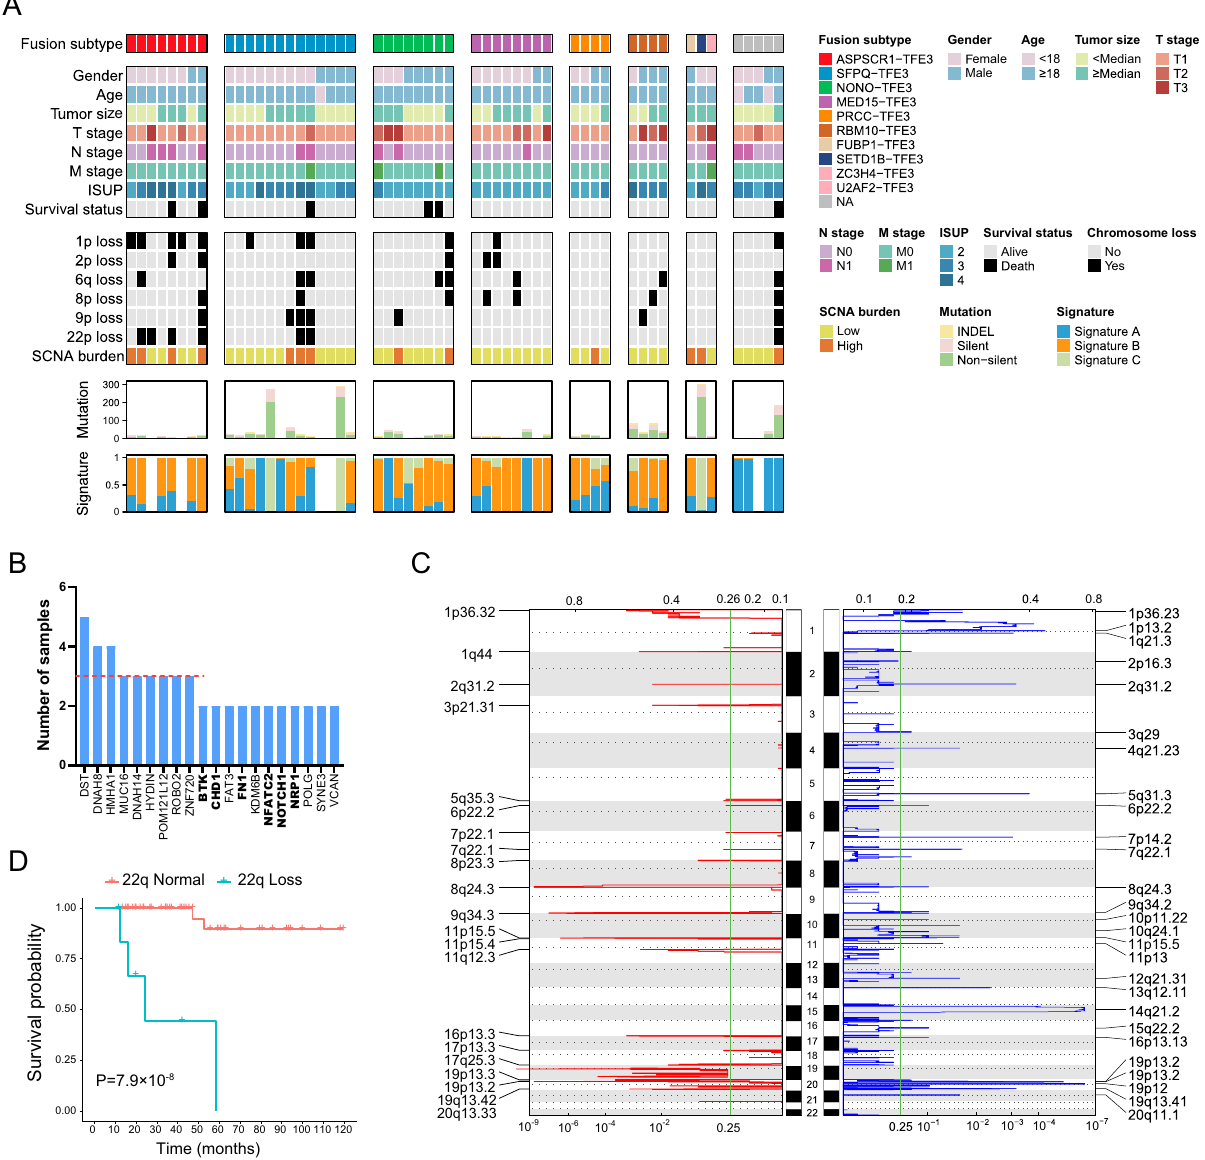
Fig. 3 The mutational landscape of TFE3-tRCC. A Clinical features and molecular data for 53 tumors (rows) are displayed as heatmaps. Each column represents an individual tumor. Patients were separated into eight groups: those with ASPSCR1-TFE3 ( n = 8), with SFPQ-TFE3 ( n = 13), with NONO-TFE3 ( n = 8), with MED15-TFE3 ( n = 8), with PRCC-TFE3 ( n = 4), with RBM10-TFE3 fusions ( n = 4), with rare TFE3 -associated gene fusions ( n = 3, including FUBP1-TFE3 , SETD1B-TFE3 , and ZC3H4-TFE3 ) and unknow partners ( n = 5). The top panel shows fusion partners. The middle panel shows clinical features, including gender, age, tumor size, TNM stage, ISUP, survival status, SCNA, and SCNA burden. Each subsequent panel displays a speci fi c molecular pro fi le: number of mutations and the fraction of each COSMIC signature in the genome. B Frequently mutated genes in the TFE3 -tRCC cohort. The red dashed line denotes three mutated patients. Tumor suppresser genes are labeled with bold font. C Focal ampli fi cation and deletion determined from GISTIC 2.0 analysis. The green line indicates the cut-off for signi fi cance ( q = 0.25). P values signi fi cantly peaks were identi fi ed at FDR q value <0.25. The top and bottom numerical values refer to G-scores and q values, respectively. D Kaplan – Meier curves show the OS between the patients with 22p loss and 22p normal. P value was determined by two-sided log-rank test. TFE3 -tRCC TFE3 -translocation renal cell carcinoma, ISUP International Society of Urological Pathology, SCNA somatic copy number alteration, OS overall